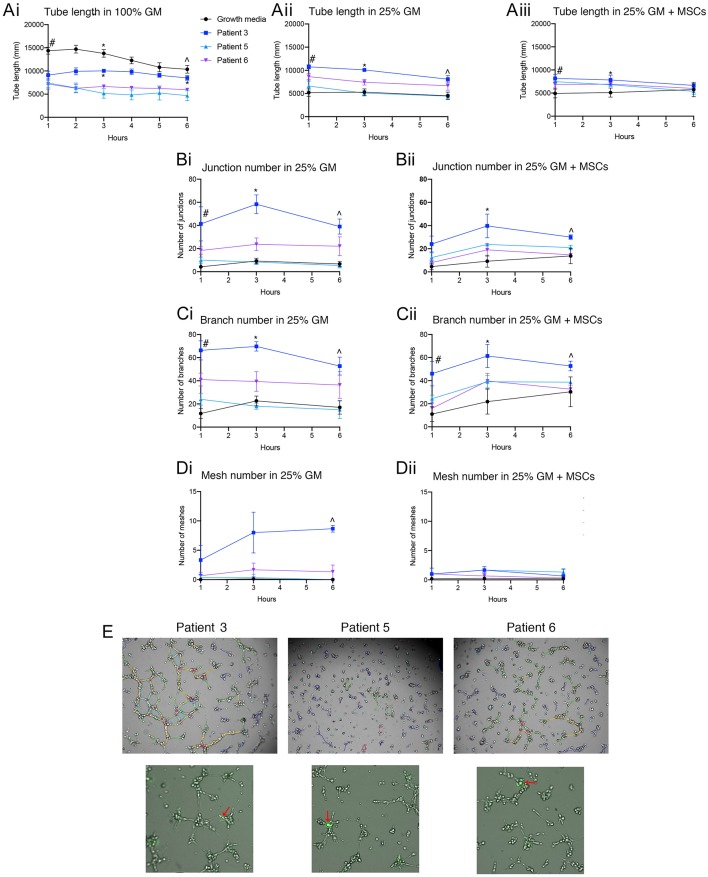
Quantification of patient-derived ECFCs angiogenic parameters over a 6 h tube forming experiment on Matrigel. Tube length was measured over 6 h in 100% GM, 25% GM, and 25% GM substituted with MSCs in both hBECs and patient-derived ECFCs (A). Junction number (B), branch number (C) and mesh number (D) were all compared between hBECs and patients-derived ECFCs cultured in 25% GM and 25% GM substituted with MSCs. Representative images of the patient tubes at 3 h demonstrate the differences in angiogenic potential between patients (E). Photomicrographs also demonstrated the presence and location of MSCs (red arrows) in culture with patient-derived ECFCs. GM, growth media, MSC, mesenchymal stem cell. Statistics: (Ai) Tube length in 100% GM: #p < 0.05 100% GM vs. patient 3, patient 5, patient 6; *All groups < 0.05 except for patient 3 vs. patient 5; ∧p < 0.05 100% GM vs. patient 5 and patient 6, patient 3 vs. patient 5 and patient 6. (Aii) Tube length in 25% GM: #p < 0.05 25% GM vs. patient 3 and patient 6; patient 3 vs. patient 5; patient 3 vs. patient 6; *All groups p < 0.05 except for 25% GM vs. patient 5 (ns); ∧p < 0.05 25% GM vs. patient 3; patient 3 vs. patient 5. (Aiii) Tube length in 25% GM + MSC: #p < 0.05 25% GM + MSC vs. patient 3 + MSC and patient 5 + MSC; ∧p < 0.05 25% GM +MSC vs. patient 6 + MSC. (Bi) Junctions: 25% GM: #p < 0.05 25% GM vs. patient 6; *p < 0.05 25% GM vs. patient 3; patient 3 vs. patient 5; patient 3 vs. patient 6; ∧p < 0.05 25% GM vs. patient 3; patient 3 vs. patient 5. (Bii) Junctions 25% GM + MSC: *p < 0.05 25% GM + MSCs vs. patient 5 + MSC; ∧p < 0.05 25% GM + MSCs vs. patient 3 + MSC; patient 3 + MSC vs. patient 5 + MSC; patient 3 + MSC vs. patient 6 + MSC. (Ci) Branch number 25%GM: #p < 0.05 25% GM vs. patient 3 and patient 6; patient 3 vs. patient 5; *p < 0.05 25% GM vs. patient 3; patient 3 vs. patient 5; patient 3 vs. patient 6; ∧p < 0.05 25% GM vs. patient 3; patient 3 vs. patient 5. (Cii) Branch number 25% GM + MSC: #p < 0.05 25% GM+MSC vs. patient 3 and patient 5 + MSC: *p < 0.05 25% GM+MSC vs. patient 3 + MSC; ∧p < 0.05 patient 1+MSC vs. patient 6 + MSC. (Di) Mesh number in 25% GM: ∧p < 0.05 25% GM vs. patient 3; patient 3 vs. patient 5; patient 3 vs. patient 6. (Dii) Mesh number 25% GM + MSC: not significant.